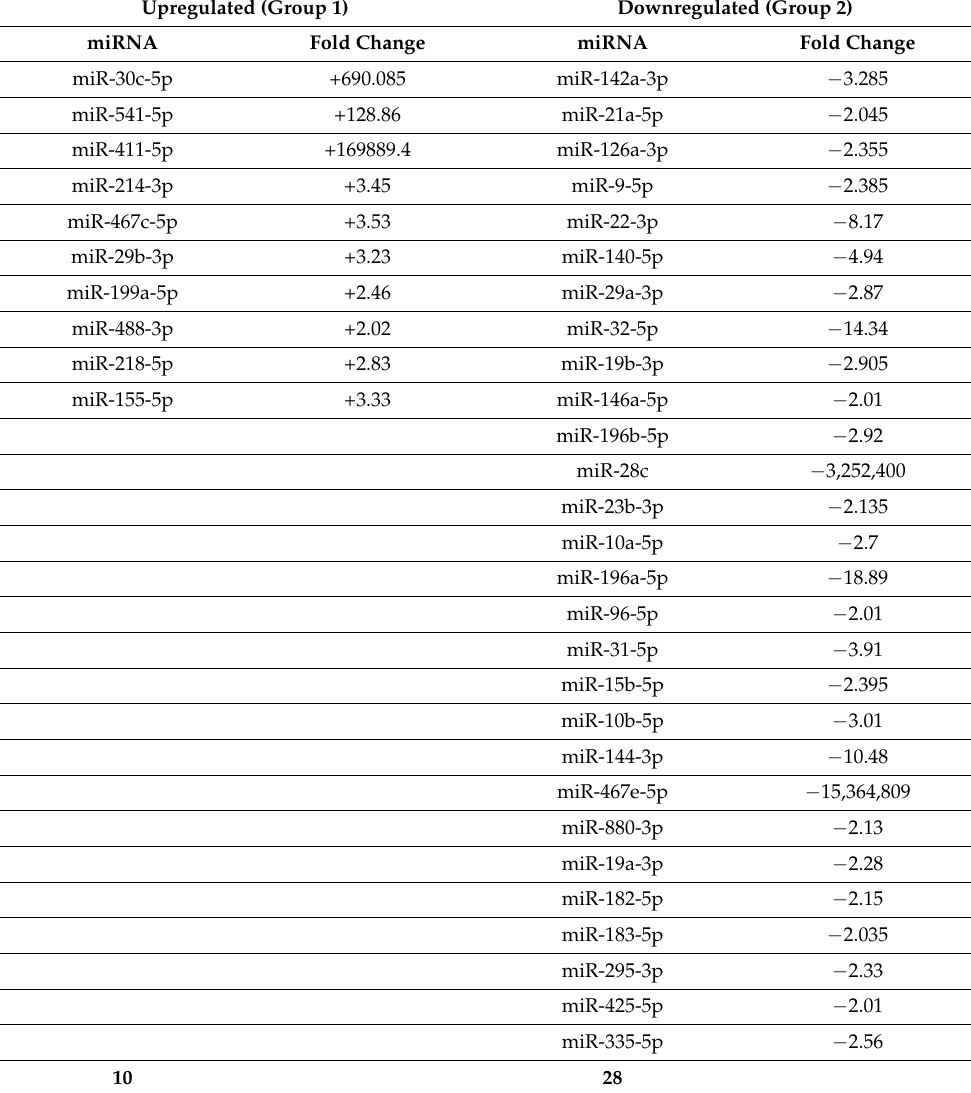
Table 1. Differentially expressed miRNAs in RANKL-stimulated RAW264.7 cells (fold change ≥ 2).